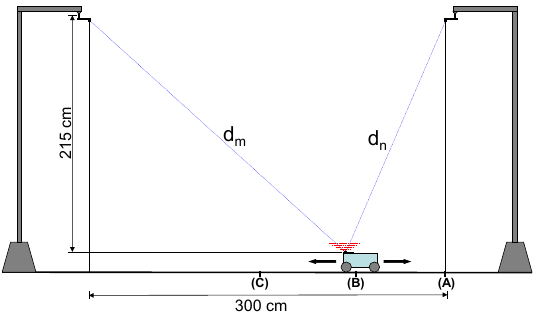
Figure 11. Setup for the real